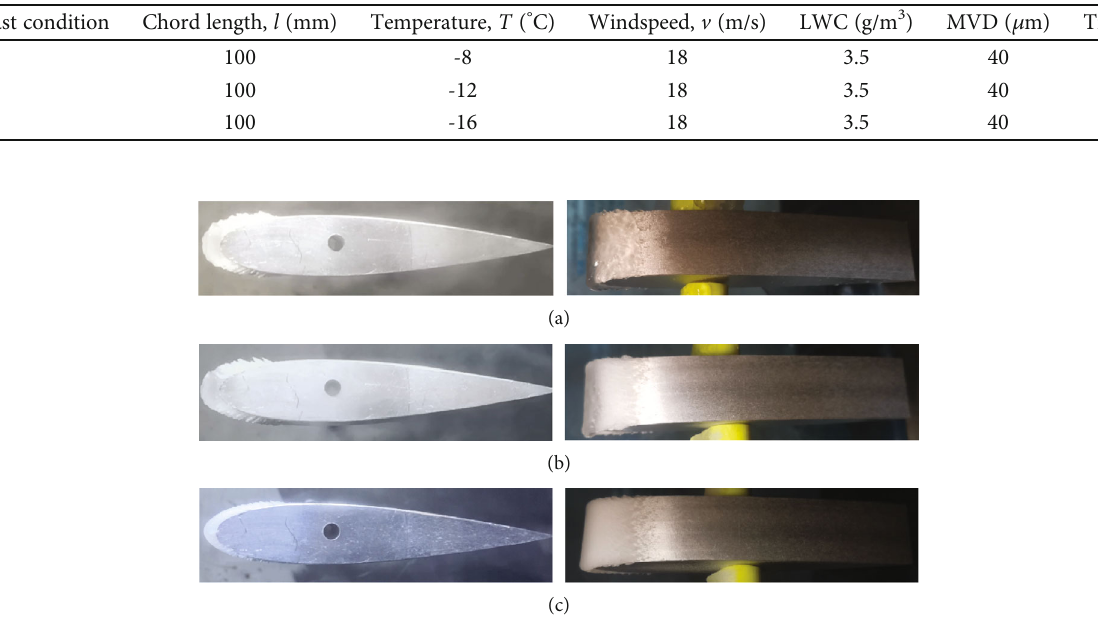
Figure 13: NACA0018 icing shape: (a) glaze ice, (b) mixed ice, and (c) rime ice.